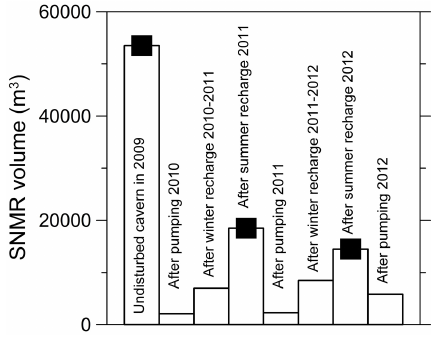
Fig. 12. Monitoring of the water volume accumulated in the cen- tral part of the Tête Rousse glacier between 2009 and 2012. Black squares show the volume after full